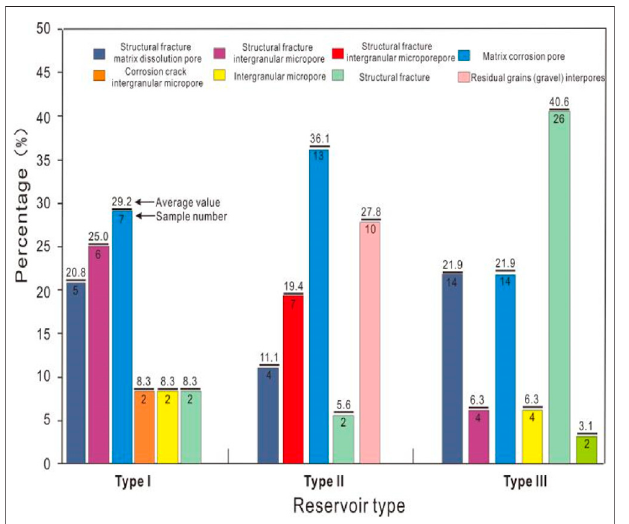
FIGURE 7 | Histogram of various reservoir spatial combinations of the volcanic reservoir in the Wangfu gas fi eld.